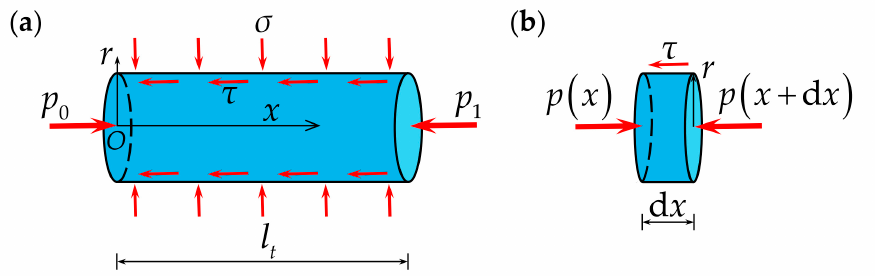
4 of 16 Figure 2. Schematic representing tortuosity. To simplify calculations, the following assumptions have been made in this research: 1.